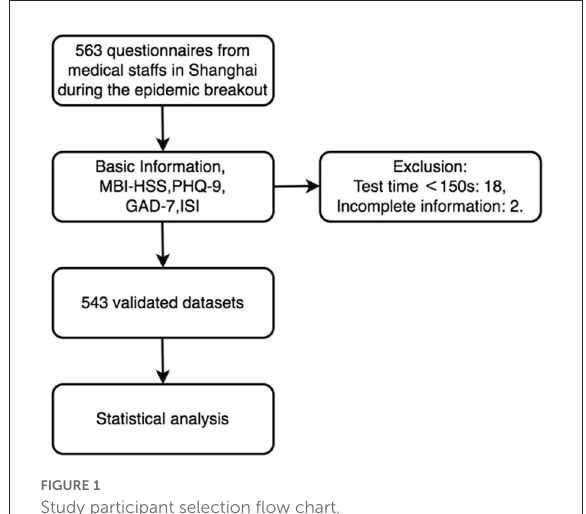
FIGURE1 Study participant selection flow